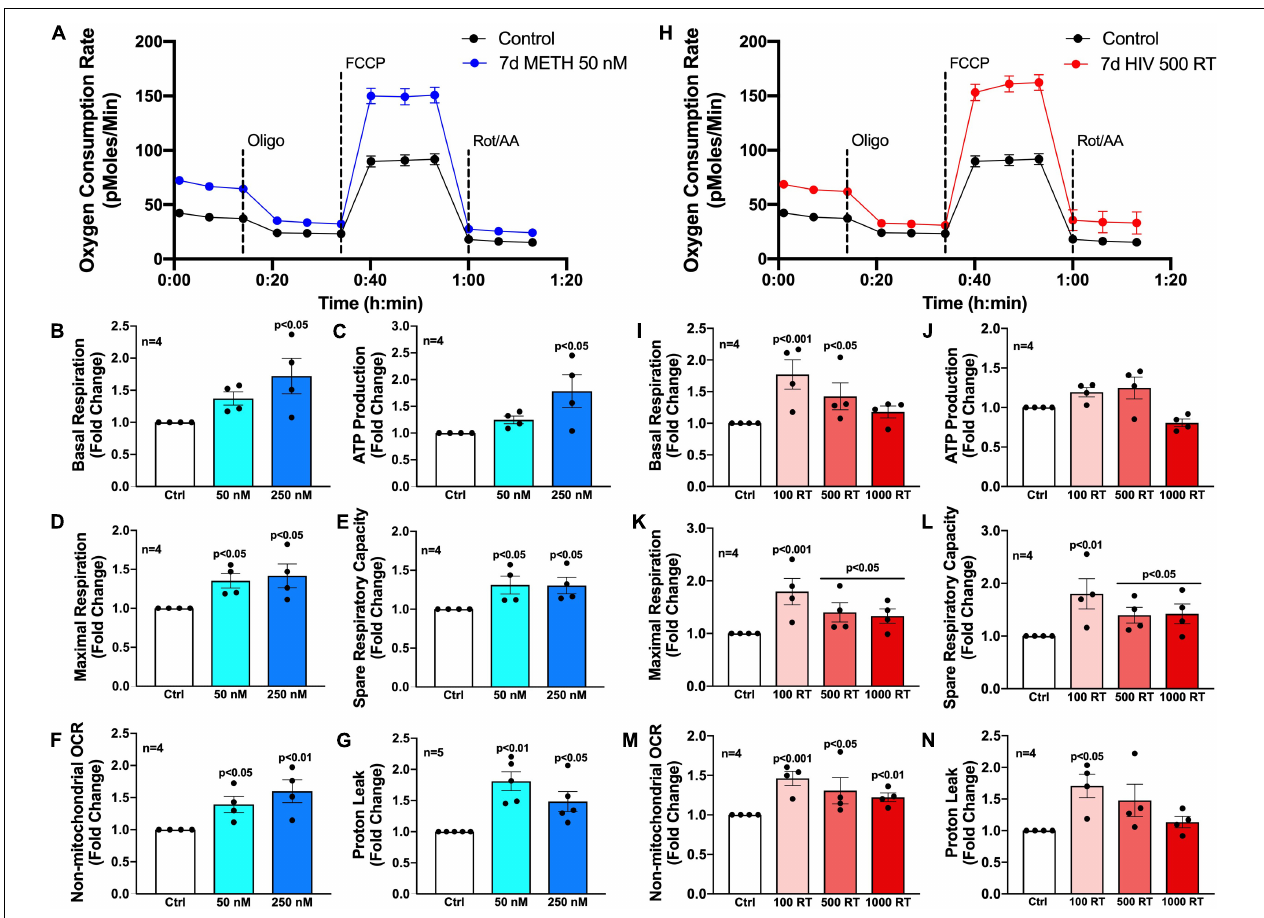
FIGURE 2 | Chronic METH exposure and HIV-1 infection increase astrocyte metabolic activity. Astrocytes were treated with (A–G) METH (50 or 250 nM) or (H–N) infected with pseudotyped HIV-1 (100–1000 RT) for 7 days prior to Seahorse XF Cell Mito Stress Test. (A,H) Representative metabolic profile tracings from a single astrocyte donor are graphed over time. Fold changes in oxygen consumption rates (OCR) quantifying (B,I) basal respiration, (C,J) ATP production, (D,K) maximal respiration, (E,L) spare respiratory capacity, (F,M) non-mitochondrial OCR, and (G,N) proton leak were graphed for statistical comparisons. Individual dots on graphs represent the averaged data from a minimum of six replicates per biological donor. Statistical significance was determined by one-way ANOVA followed by Tukey’s post hoc for multiple